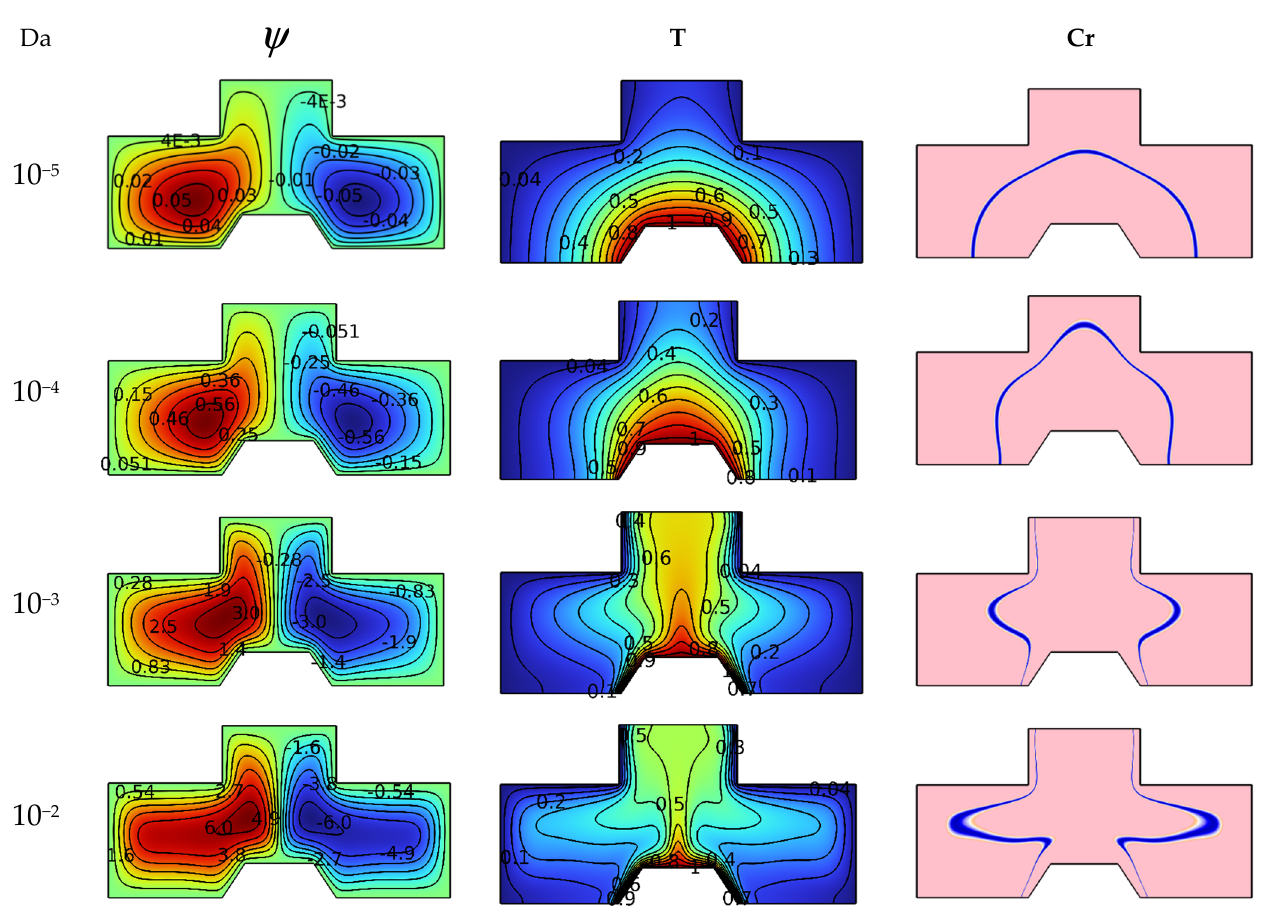
Figure 5. Da number influence on streamlines, isotherms, and Cr for Ra = 10 5 , Ha = 0, and φ = 4%.